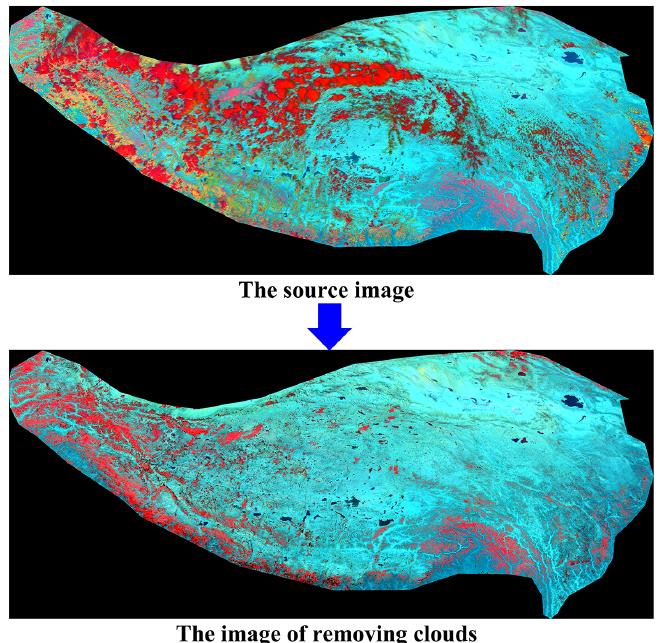
Figure 7. The cloud-removed image, and its source image of the whole Qinghai–Tibet Plateau.